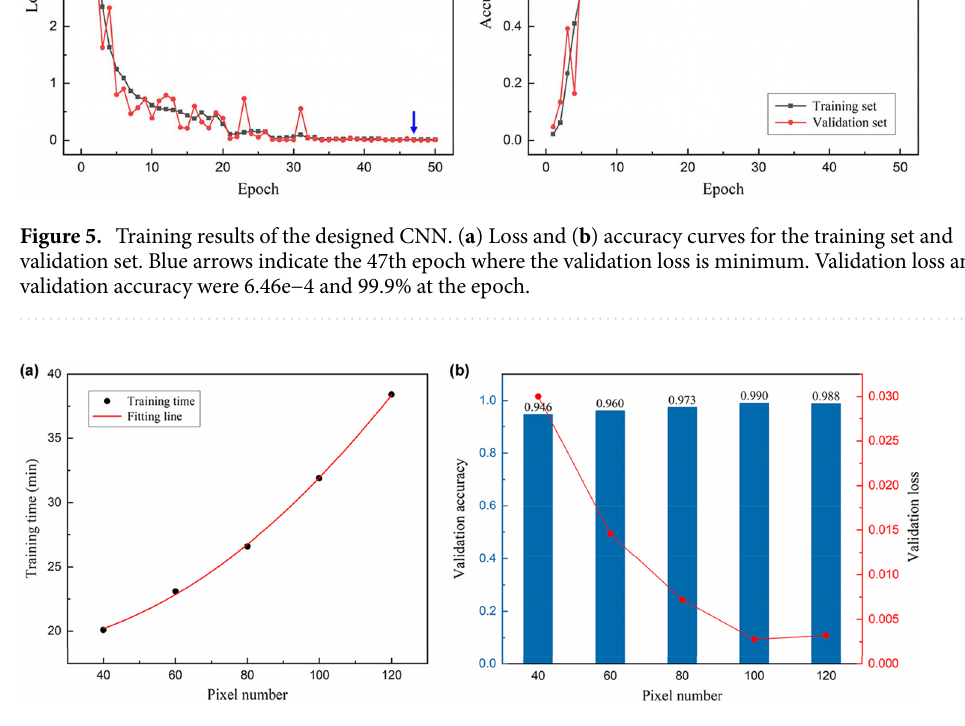
Figure 6. Performance evaluation of the number of input image pixels. ( a ) Time taken to train for 50 epochs and ( b ) validation loss and validation accuracy. All data show mean values of 10 training results per pixel